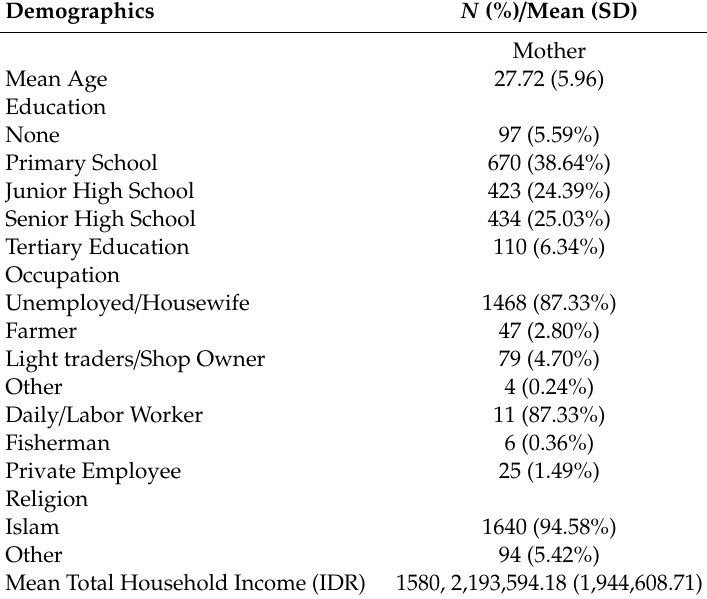
Table 1. Participant demographics, N =